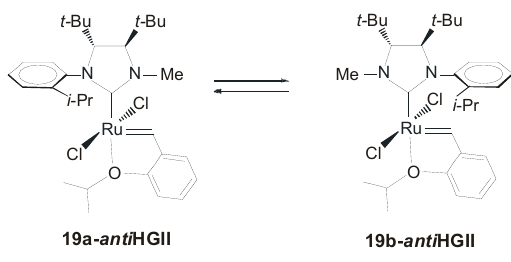
Figure 15. Rotational isomers of 19- anti HGII .